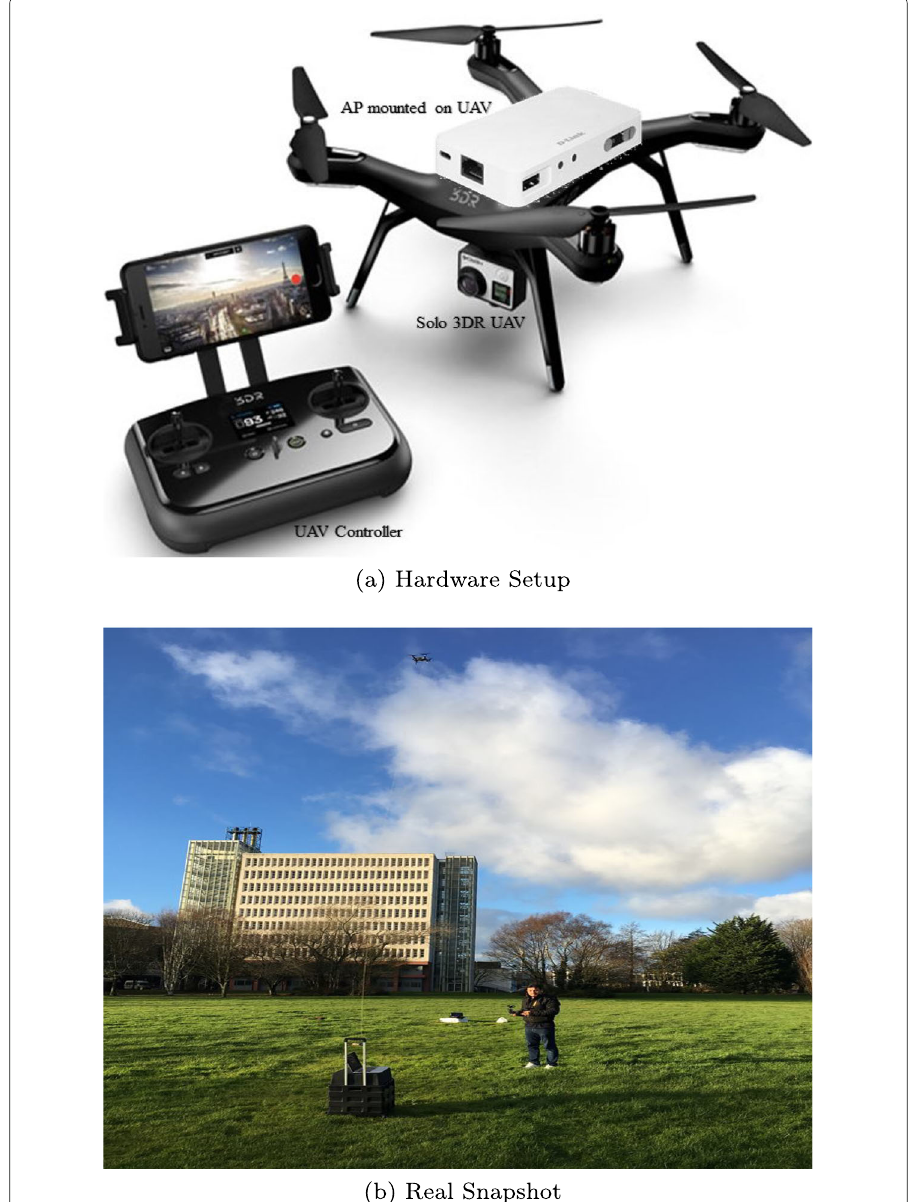
Fig. 2 Solo quadrocopter with its controller and AP along with a real snapshot of the testbed